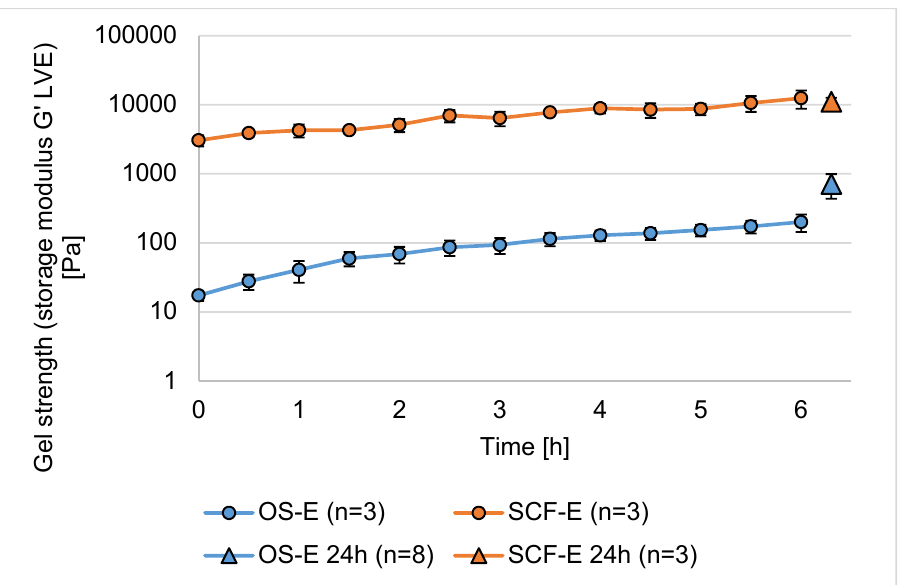
Figure 7. Gel strength (amplitude sweep) during the first six hours of gel formation for organic solvent and supercritical fluid extract gel (six percent extract in oil); mean ± SD.